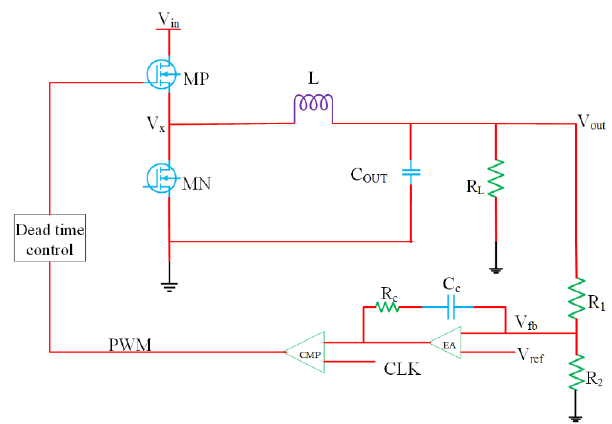
Table 3. Performance comparison of step-down DC-DC converter designs based on on-chip-integrated passive elements. Parameters